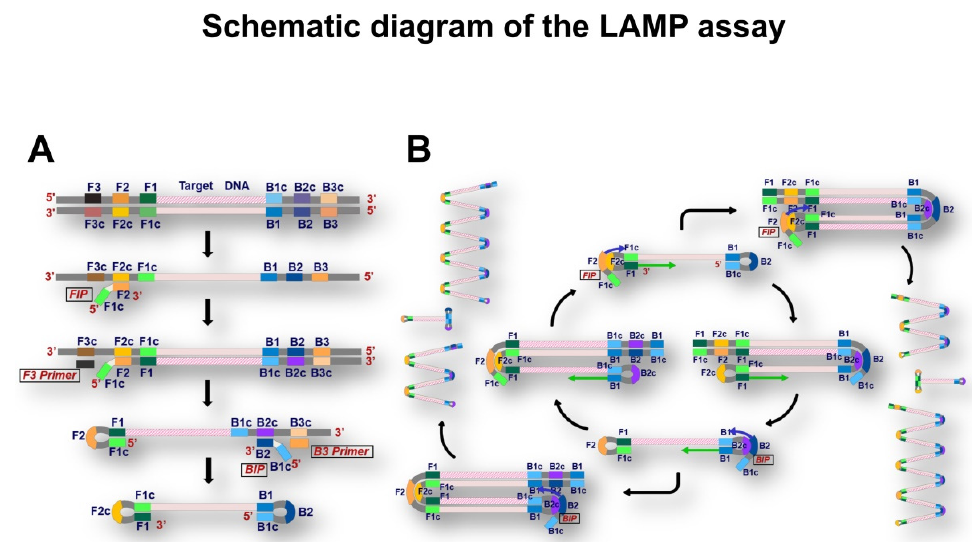
Figure 2. Schematic diagram of loop-mediated isothermal amplification. ( A ) Scheme of dumbbell-like structure formation. Target DNA is firstly denatured into single-stranded DNA. Then, the forward inner primer (FIP) initiates DNA synthesis from the F2c region. The following extension from the forward outer primer (F3) displaces the strand that was generated by the FIP extension. The replaced strand plays the role of a template of the backward inner primer (BIP) and backward outer primer (B3) in the same manner as sense strand amplification. Consequently, the dumbbell-like structure harboring hairpin structure on both of 5 ′ - and 3 ′ -terminus is generated. ( B ) Scheme of isothermal amplification. The dumbbell-like structure exposing F2c or B2c regions where FIP or BIP hybridizes initiates cycling amplification. The cycling amplification regenerates dumbbell-like structures and generates various amplicons, which are exponentially increased in length.